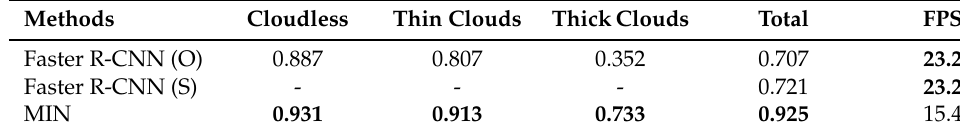
Table 1. Average precision (AP) with single-modal and multi-modal images.